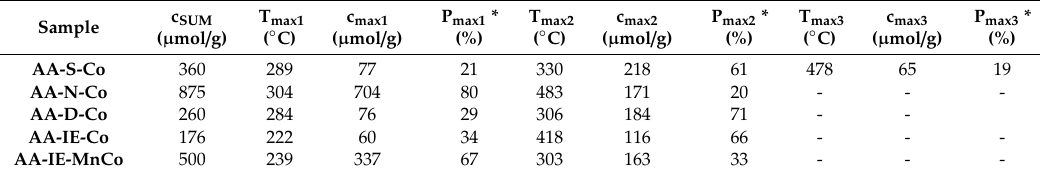
Table 4. Reducibility of cobalt catalysts determined by TPR.